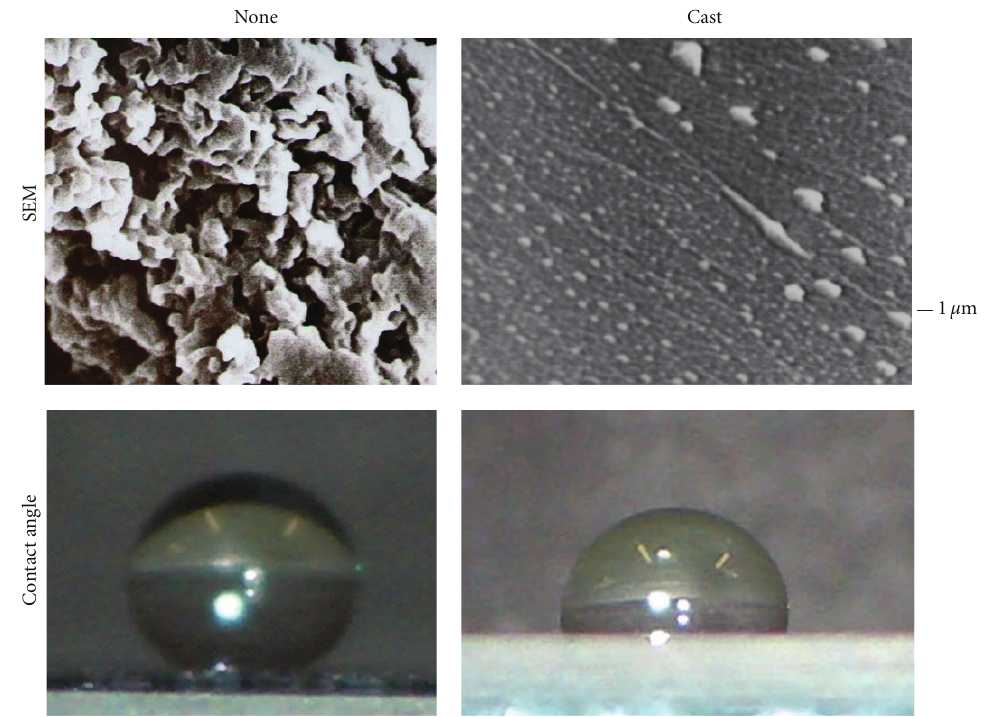
Figure 19: SEM images of the random forms produced by the copolymer and of the surface on the cast films. Also shown are photographs of water droplets placed on the surface of the random forms produced by the copolymer and of the surface on the cast